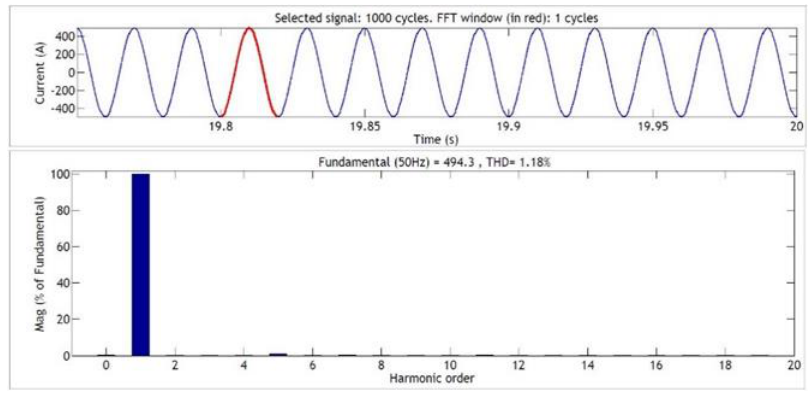
Figure 17. After compensation source current FFT analysis.